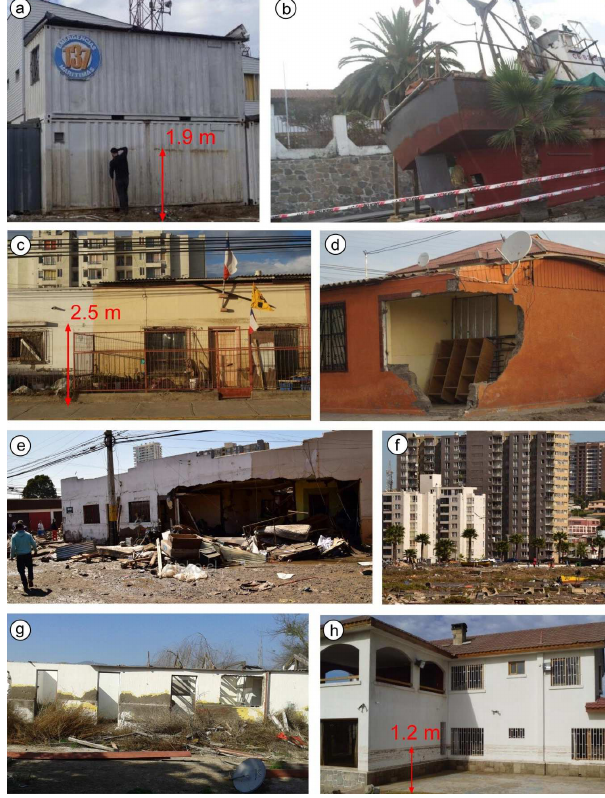
Figure 4. (a) Building with average RVI score in the first coastline with flow depths of 1.9m after the 2015 tsunami in Coquimbo Port (sector 1). (b) Movable objects impacting residential buildings after the 2015 tsunami. (c) High vulnerability building with more than 50% of its infrastructure flooded. (d) High vulnerability building with its damaged infrastructure after the 2015 tsunami. (e) Very high vulnerability building that resulted in non-repairable damage after the 2015 tsunami. (f) Modern buildings with minor vulnerability RVI score. (g) Very high vulnerability building highly affected by the tsunami in La Cantera sector. (h) Not open plan ground